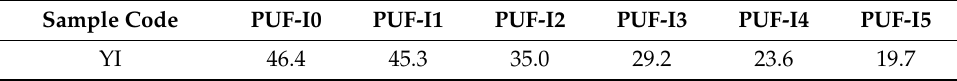
Table 5. YI of the FPUFs after thermal treatment at 160 ◦